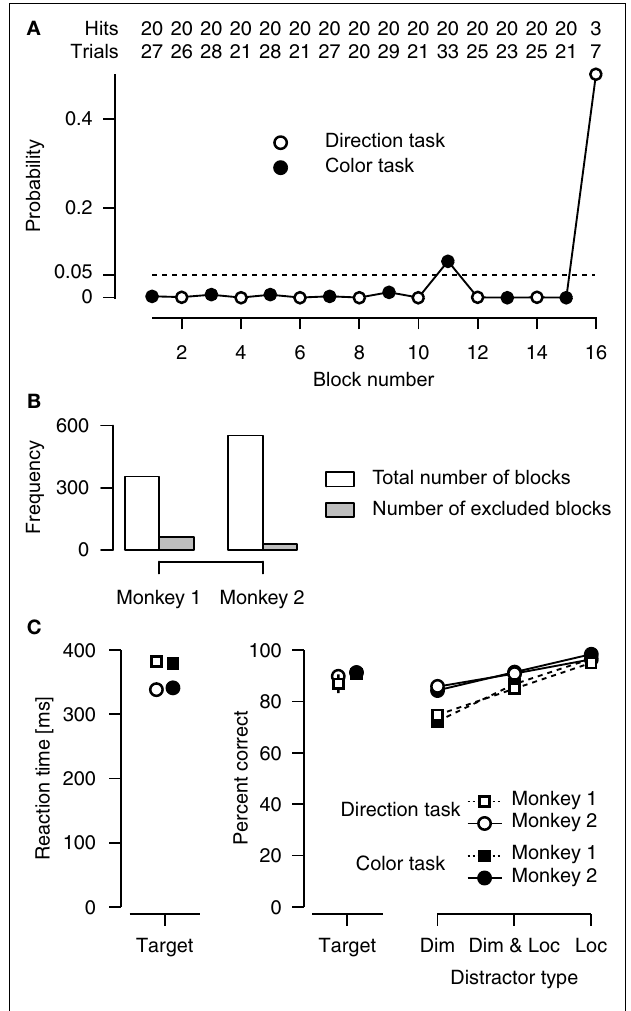
FIGURE 2 | Analyses of behavioral performance. (A) Blockwise analysis of overall behavioral performance. Shown is a single recording session during which monkey 1 performed 16 blocks of color (fi lled circles) and direction (open circles) tasks, alternating with every 20 correctly completed trials. Rows at the top indicate the number of correct trials (i.e., trials in which the target was detected or a distractor was successfully ignored) and the total number of trials (including correct trials and trials in which the target was missed or a response to a distractor was given, excluding trials that were terminated because of fi xation breaks), separately for every block. The data points indicate, for every single block, the probability of achieving this level of performance by chance. The dashed line at p = 0.05 marks the criterion for including individual blocks in all subsequent analyses. In this particular session, blocks 11 and 16 were excluded (in the last block the monkey only performed 7 trials, after which the recording session was ended). (B) Total number of blocks and number of excluded blocks, separately for each monkey. (C) Average performance for targets and for the different distractor types. Included are only blocks that meet the behavioral performance criterion defi ned in (A) . Error bars indicate 95%-confi dence intervals for the mean (Loftus and Masson, 1994; Wright, 2007). Dim, Distractor in the wrong dimension; Loc, Distractor at the wrong